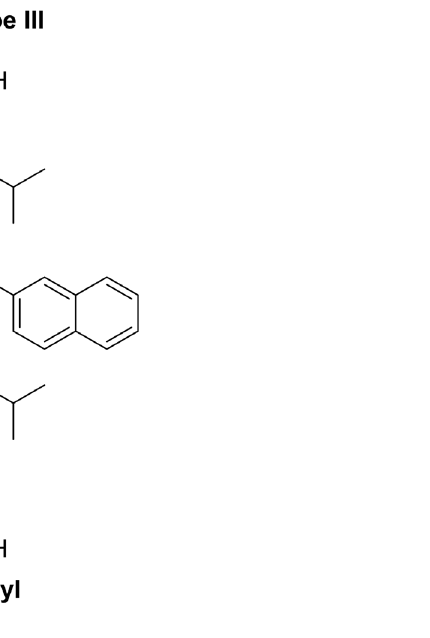
Fig 1. Examples of type II and III inhibitors previously reported.